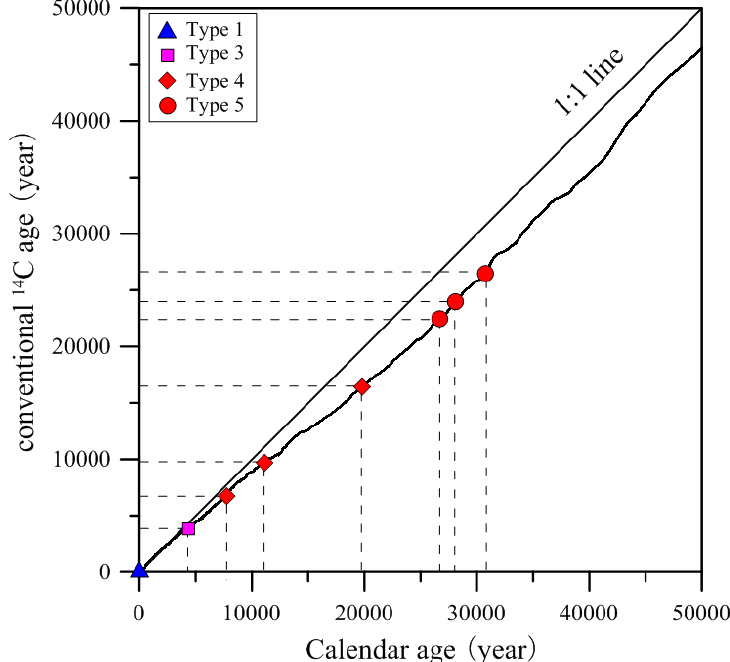
Figure 12. The curve for the calibration of groundwater 14 C ages: This curve is for the northern hemisphere IntCal13. The diagonal line shows where the curve would lie if the conventional 14 C and calendar ages are the same.